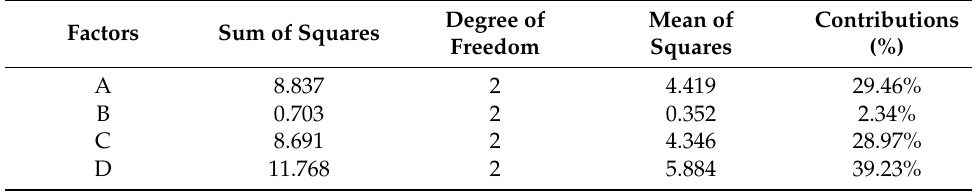
Table 8. Variance analysis on the MPCI results.